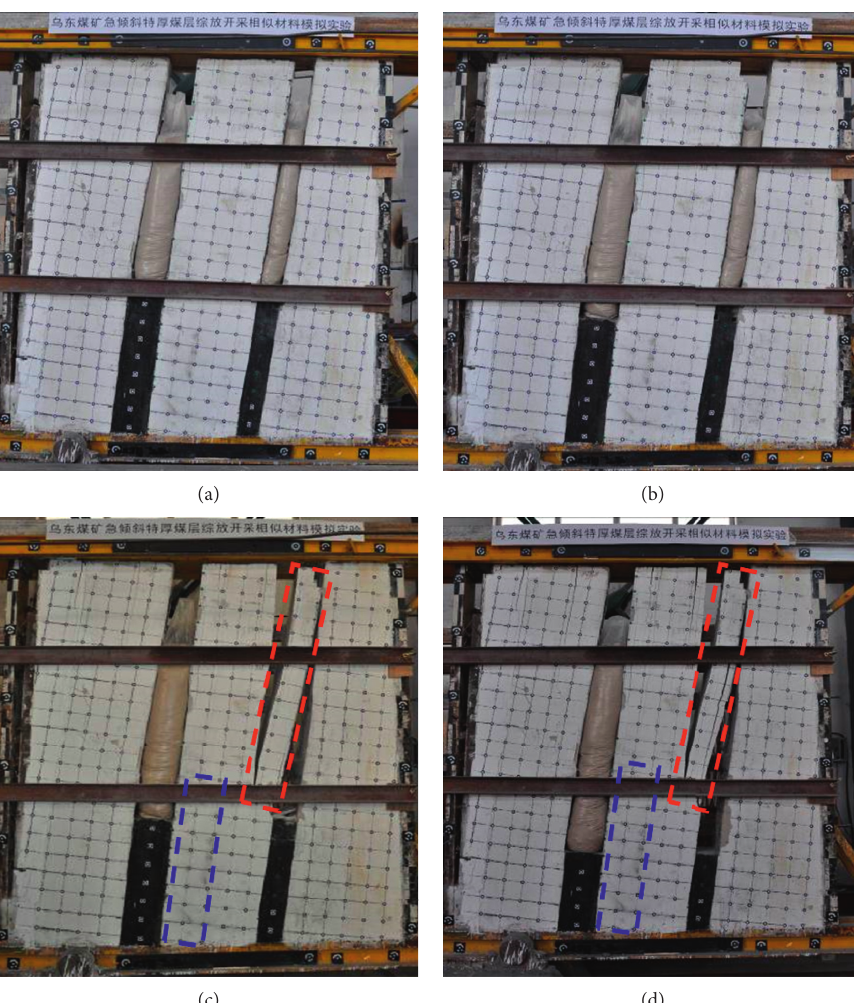
Figure 5: The characteristic of fracture at different levels. (a) +525 m level. (b) +500 m level. (c) The filling body was removed. (d) +450 m